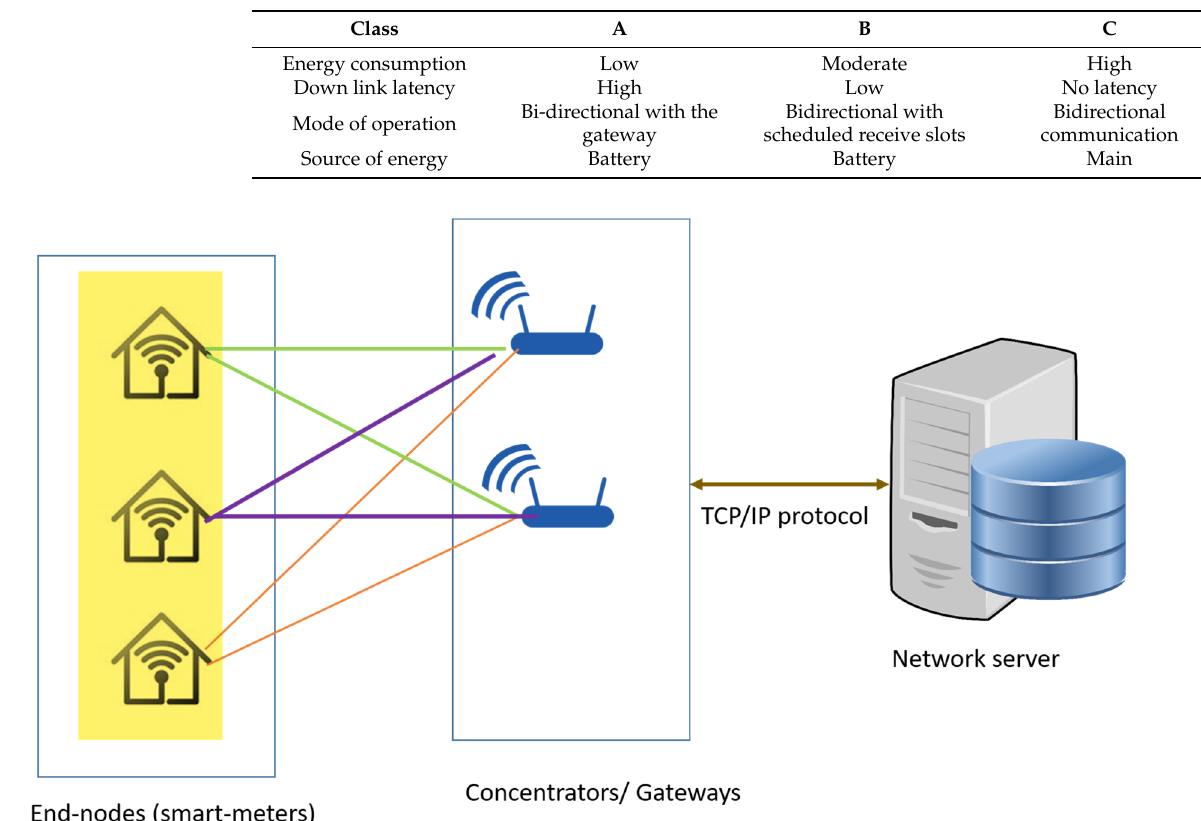
Figure 13. Schematic representation of LoRaWAN network architecture.